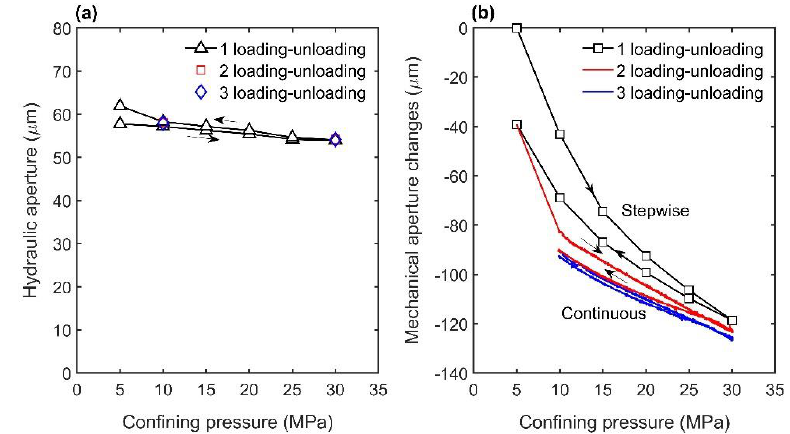
Figure 4. Hydraulic fracture aperture as a function of temperature at constant pore pressure (1 MPa) and constant confining pressure (10 MPa).